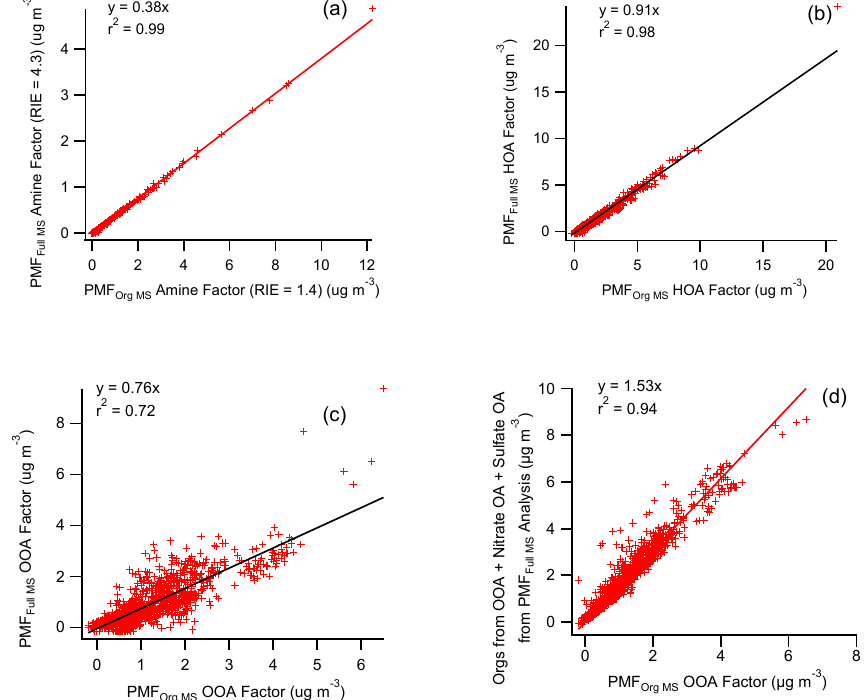
Figure 13. Scatter plots Amine (a) , HOA (b) , and OOA (c, d) factors comparing their mass derived from PMF Full MS vs. PMF Org MS analyses. One observation (31 January 2005, 21:00LT) was removed from the HOA comparison to enhance the fit of the